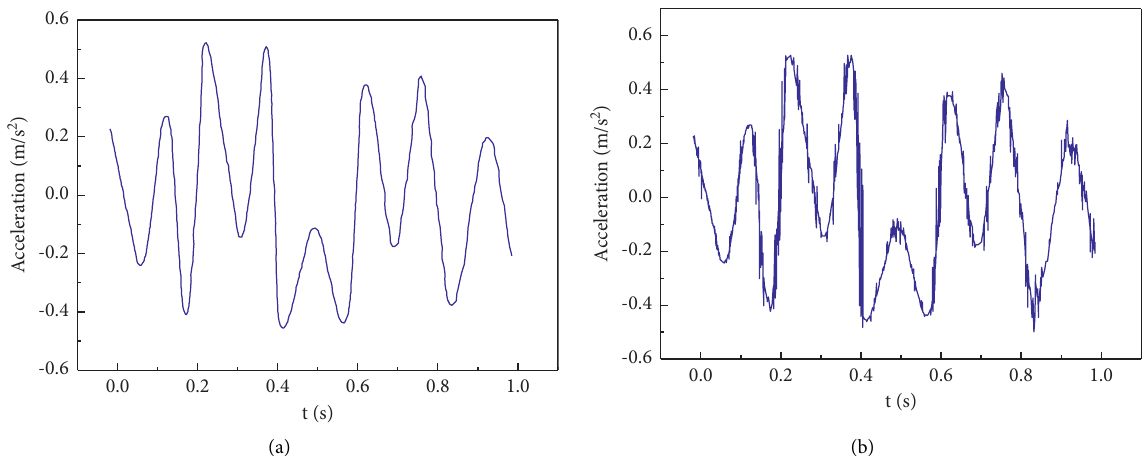
Figure 9: Reconstructed building vibration signal based on decomposed IMFs by IEMD-IWFD and EMD.